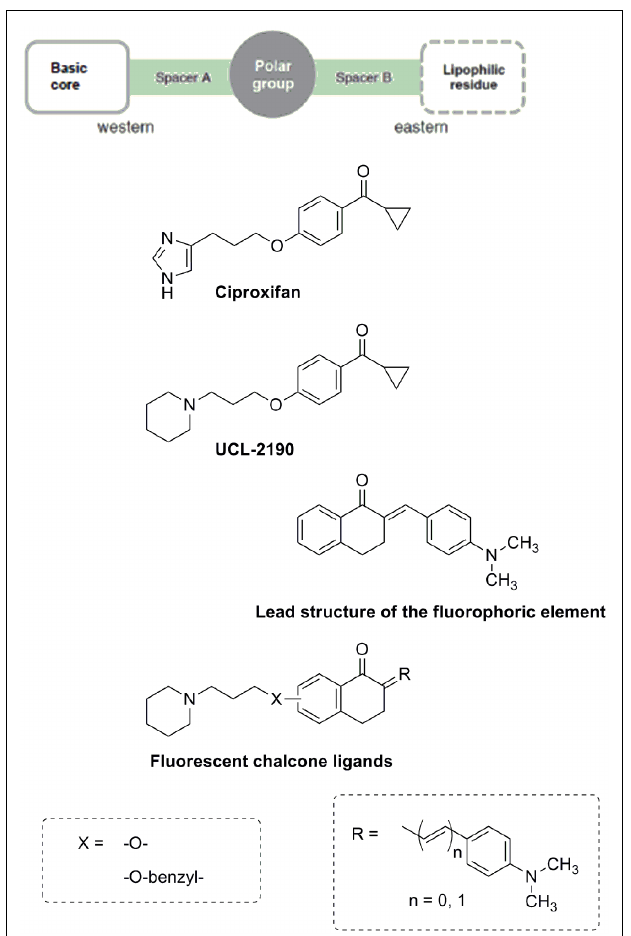
FIGURE 1 | Design strategy for novel fluorescent human histamine H 3 receptor ligands.